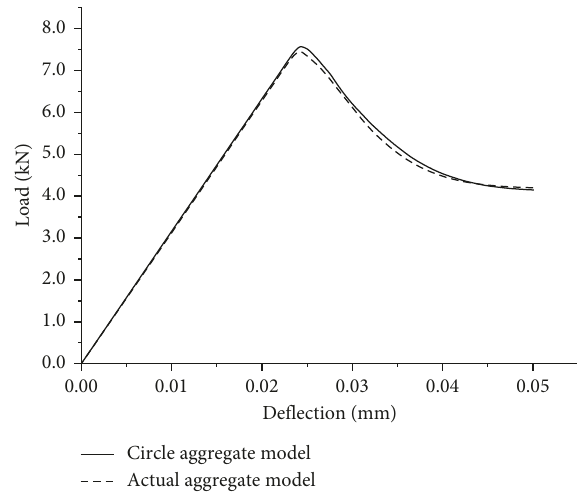
Figure 14: Load-deflection